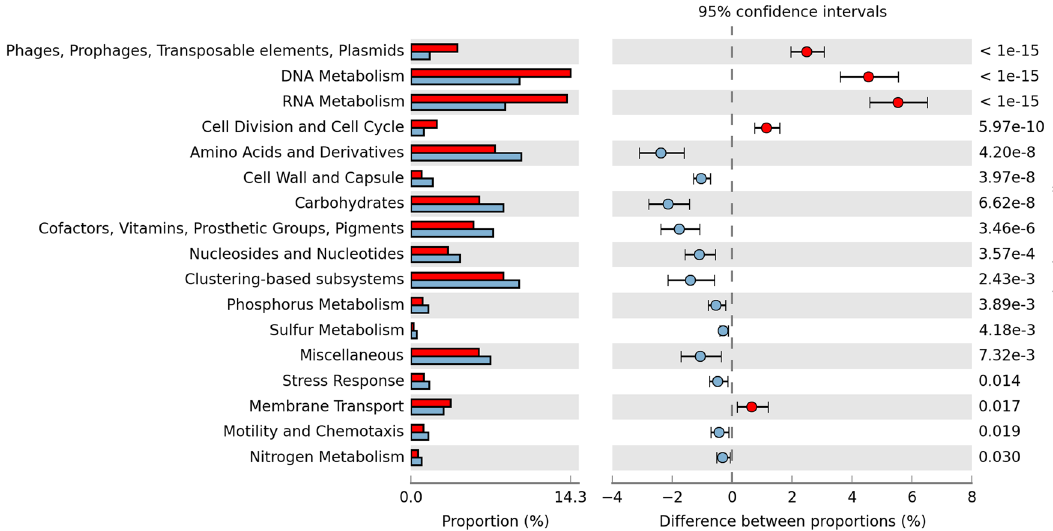
Figure 6. Predicted functional profiles derived from the plasmidome (red bars) and the metagenome (blue bars) of Diamante Lake red biofilm. Percent SEED categorizable protein-encoding genes and pairwise proportional differences calculated using STAMP. G-test (w/Yates’) was used and corrected P-values were calculated using Benjamini–Hochberg’s FDR. Only the statistically significant SEED subsystems are shown (q <